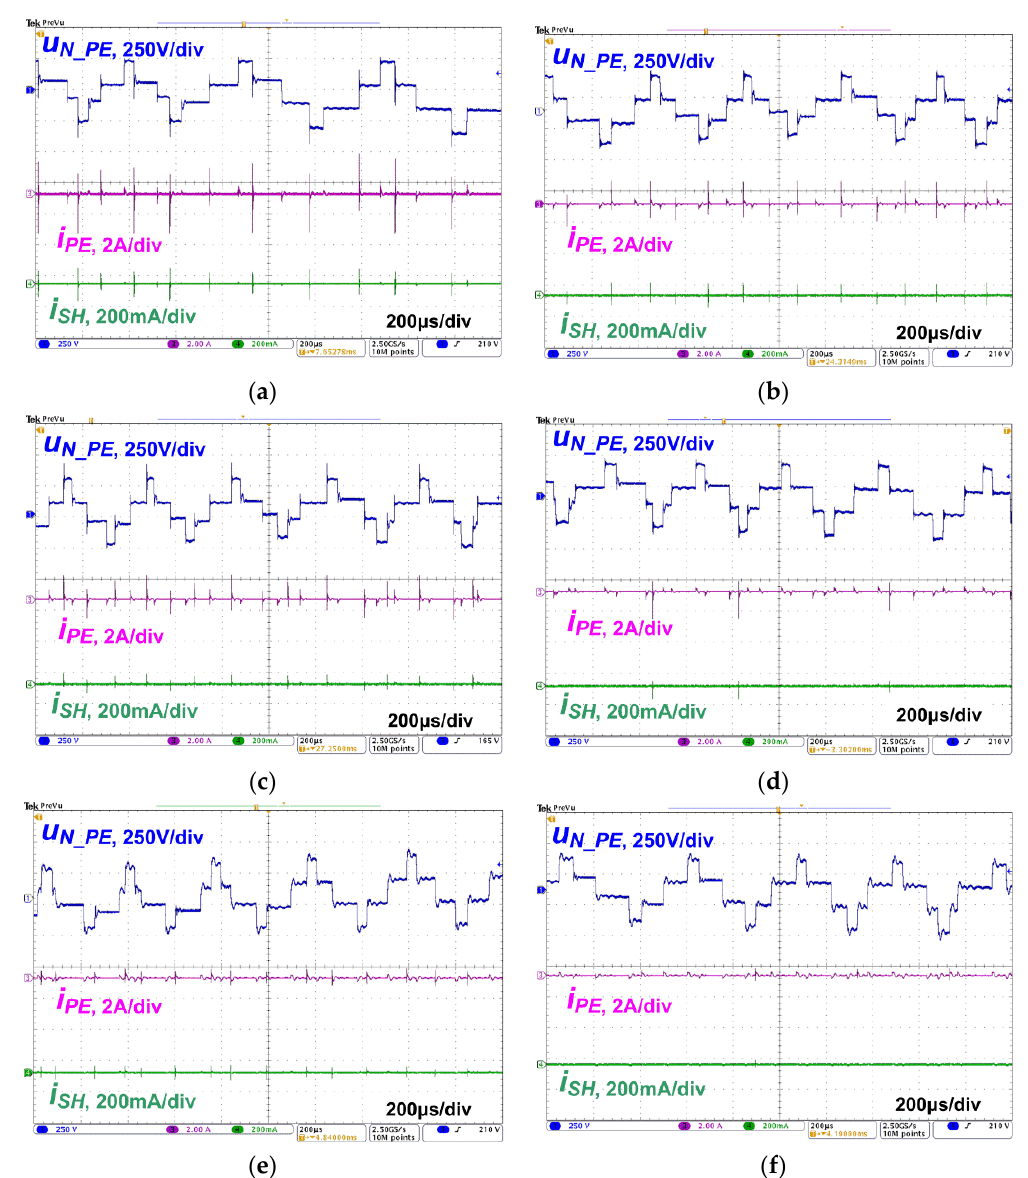
Figure 29. Experimental waveforms of CM voltage u N_PE , leakage current i PE and shaft-grounding brush current i SH measured in a configuration with a 10 m cable for: ( a ) inverter; ( b ) motor choke; ( c ) du/dt choke; ( d ) sine-wave filter; ( e ) CM choke; ( f ) CM choke with sine-wave filter.